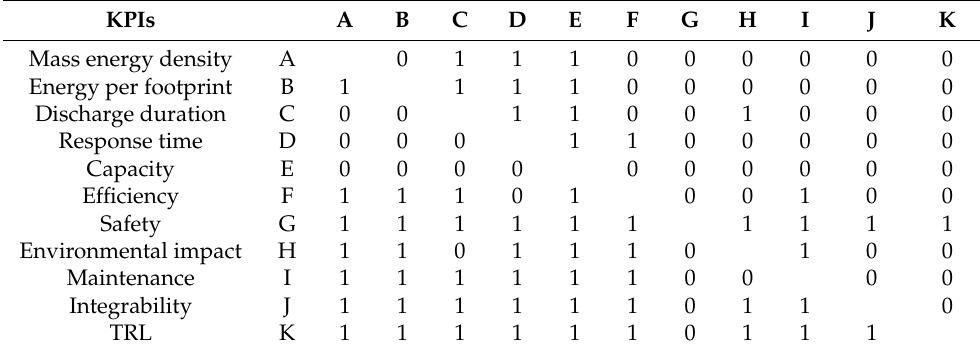
Table A1. KPI comparison matrix (Scenario A).